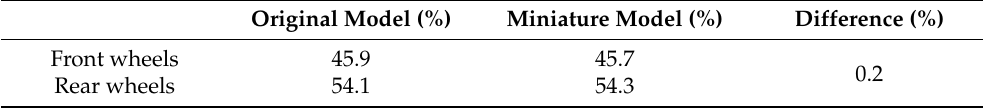
Table 3. Comparison of weight distribution between the original and reduced